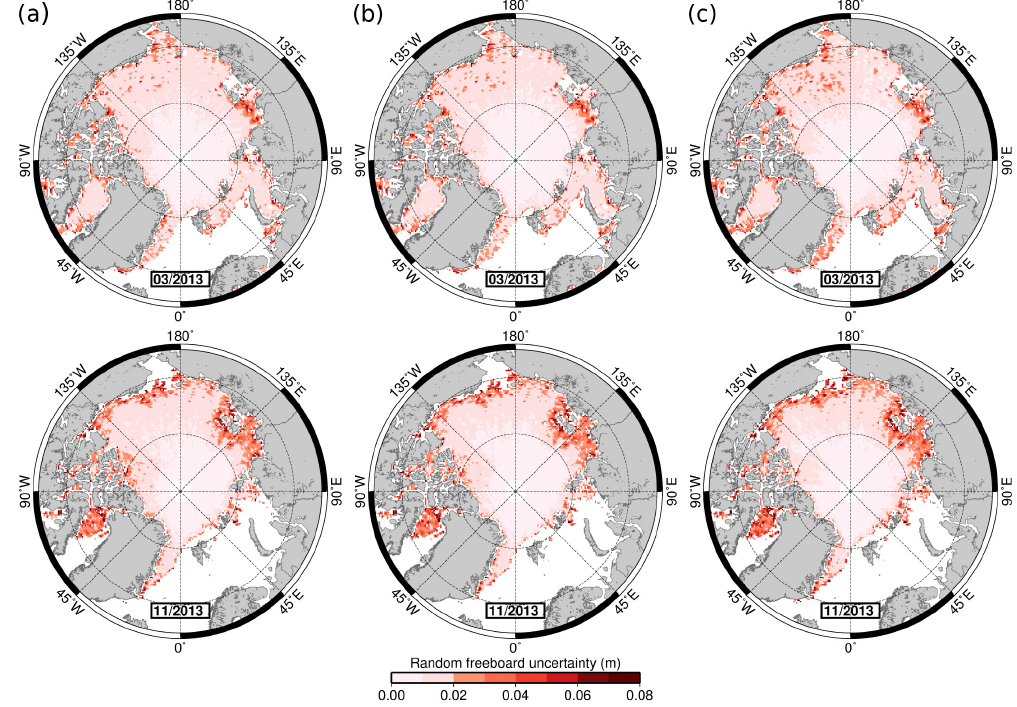
Figure 10. Random freeboard uncertainties corresponding to Fig. 9: (a) TFMRA40, (b) TFMRA50 and (c) TFMRA80. The uncertainties result from Gaussian propagation of uncertainty (Fig.